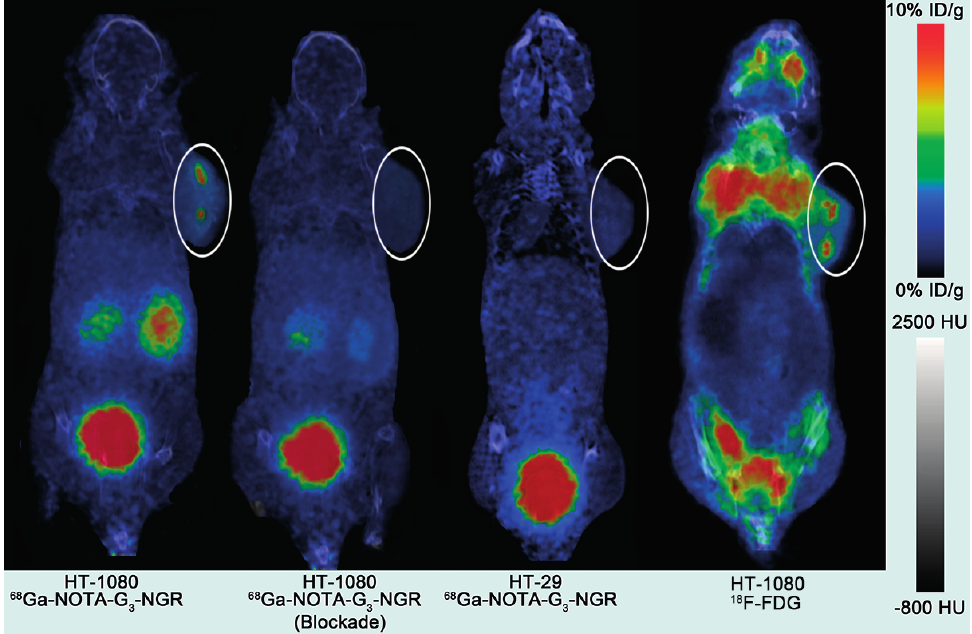
HT-1080 and HT-29 tumor xenografts with and without co-injection of non-radiolabeled -NGR peptide as a blocking agent. As a comparison, decay-corrected coronal NOTA-G 3 image slice at 1 h pi of 18 F-FDG in HT-1080 tumor xenografts was also shown. Tumors are indicated using